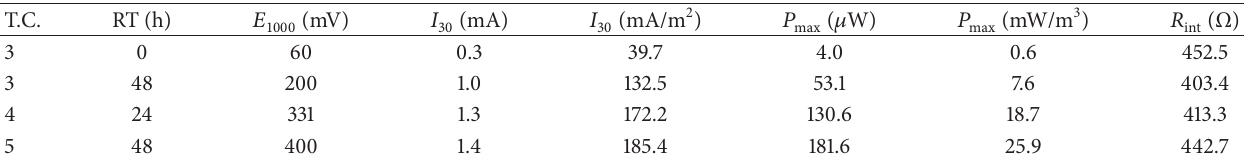
Table 4: MFC feeding with SW2 wastewater. Polarization curves overview throughout three consecutive treatment cycles. 𝐸 1000 represents the cell voltage at external resistance of 1000 Ω , 𝐼 30 represents the current intensity at external resistance of 30 Ω . T.C.